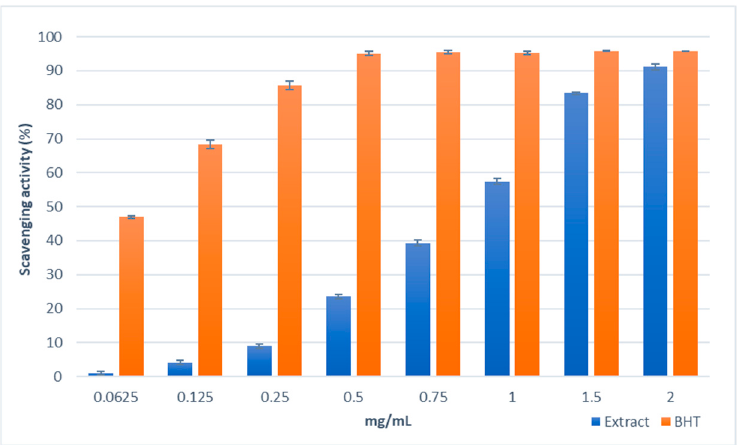
Figure 2. Free radical scavenging activity (DPPH test) of the methanol extract obtained from biomass of in vitro culture of Scutellaria brevibracteata subsp. subvelutina (3.0 mg/L BAP and 1.0 mg/L NAA). Values are expressed as the mean ± SD ( n = 3).